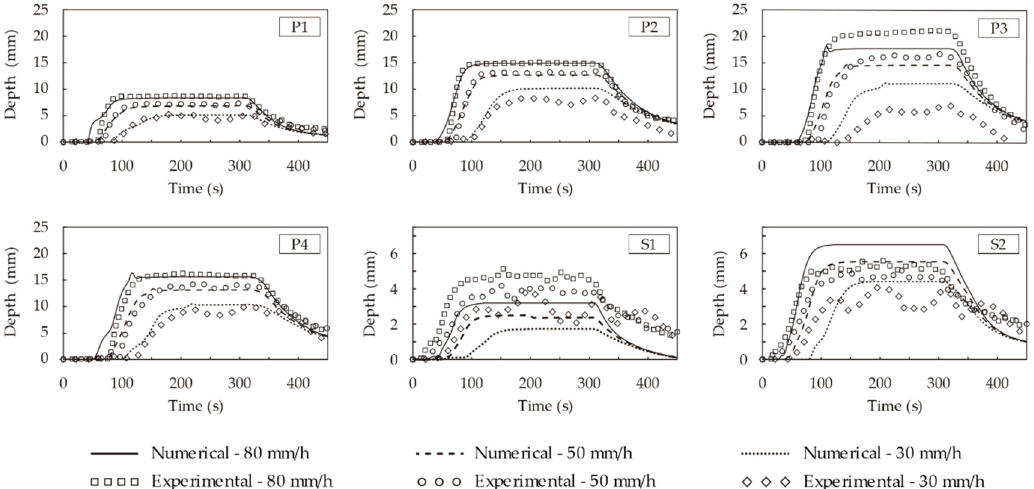
Figure 9. Experimental and numerical profiles of depths in pipes at control points P1 ( top-left ), P2 ( top-middle ), P3 ( top-right ) and P4 ( bottom-left ) and in surface at control points S1 ( bottom-middle ) and S2 ( bottom-right ).